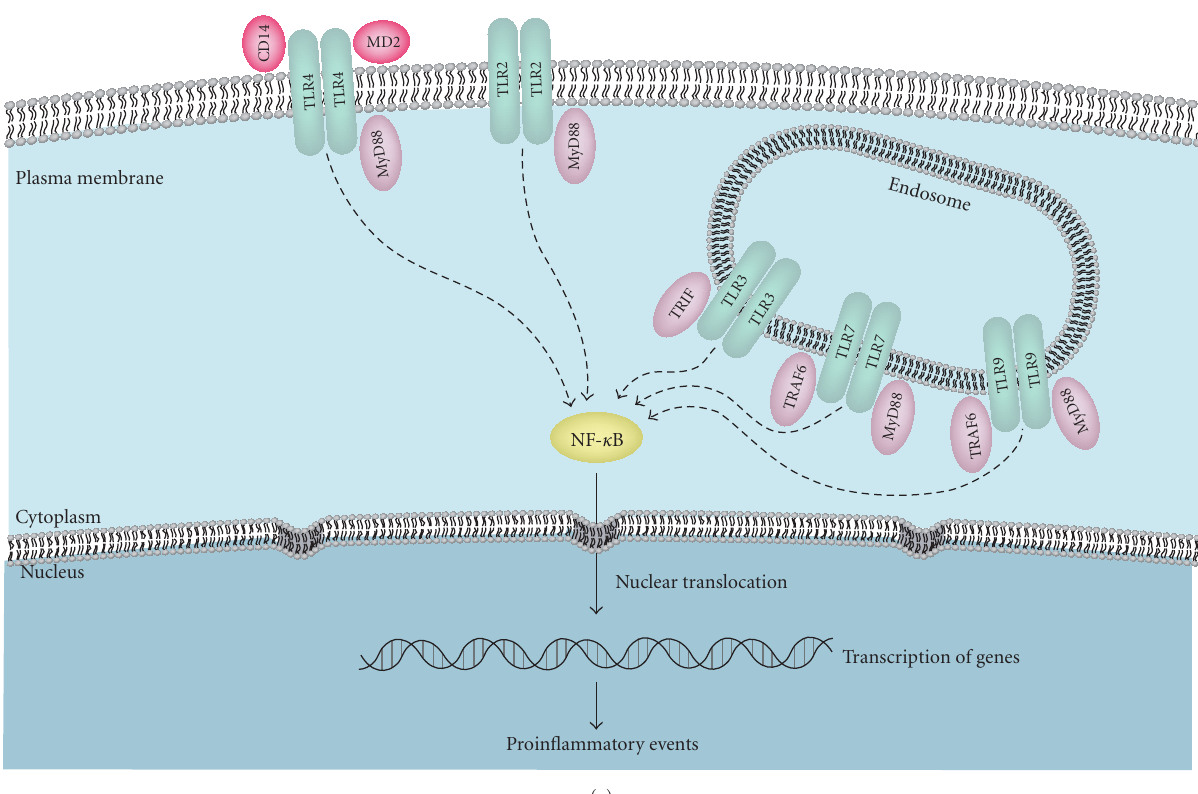
Figure 1: (a) Cross-section of epidermis. Keratinocytes are present throughout the skin; other epidermal cell types include Langerhans cells, melanocytes, and merkel cells. (b) Keratinocytes express TLRs 1, 2, 3, 4, 5, 9, and 10. MD2: TLR4-associated molecule; MyD88: myeloid di ff erentiation factor 88; NF- κ B: nuclear factor- κ B; TRAF-6: TNF receptor-associated factor-6; TRIF: TIR domain-containing adapter protein that induces IFN- β . (c) Langerhans cells express high levels of TLRs 2, 3, 4, 8, and 10. but express low levels of TLRs 1, 5, 6, 7, and 9. (d) Upon activation, myeloid-derived dendritic cells and to a lesser extent keratinocytes release IFN α and IL-18 which stimulate Langerhans cell maturation. With antigen stimulation the Langerhans cell induces a Th1 response. (e) In response to TLRs 2, 3, 4, 7, and 9 melanocytes initiate proinflammatory events via the illustrated